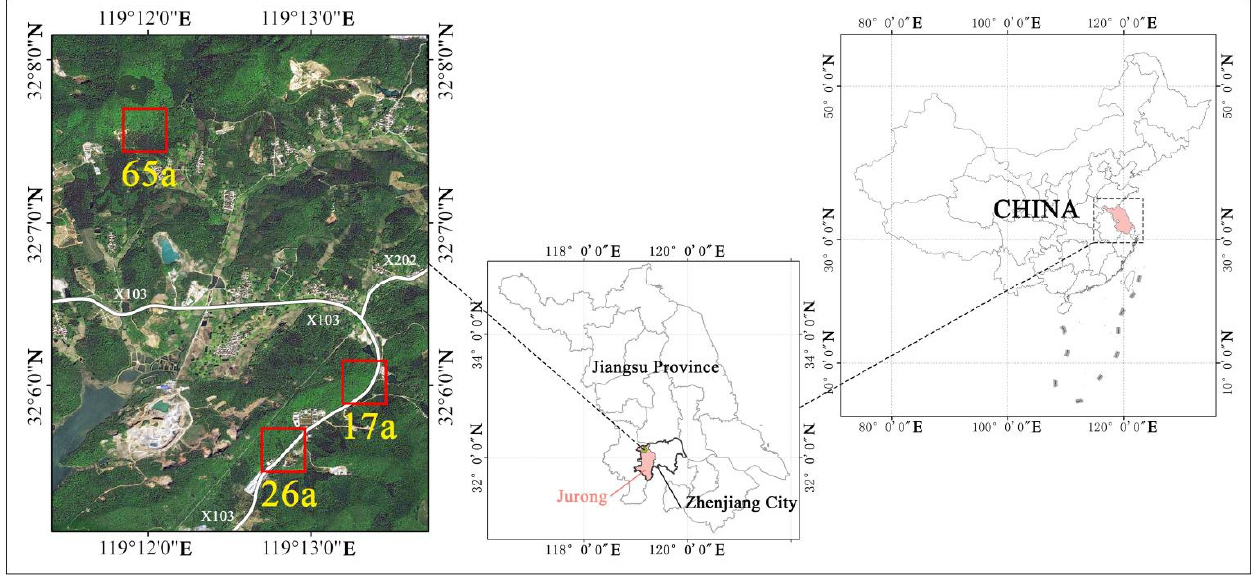
Figure 1. Location of the study site. 17a, 17-year-old stand; 26a, 26-year-old stand; 65a, 65-year-old